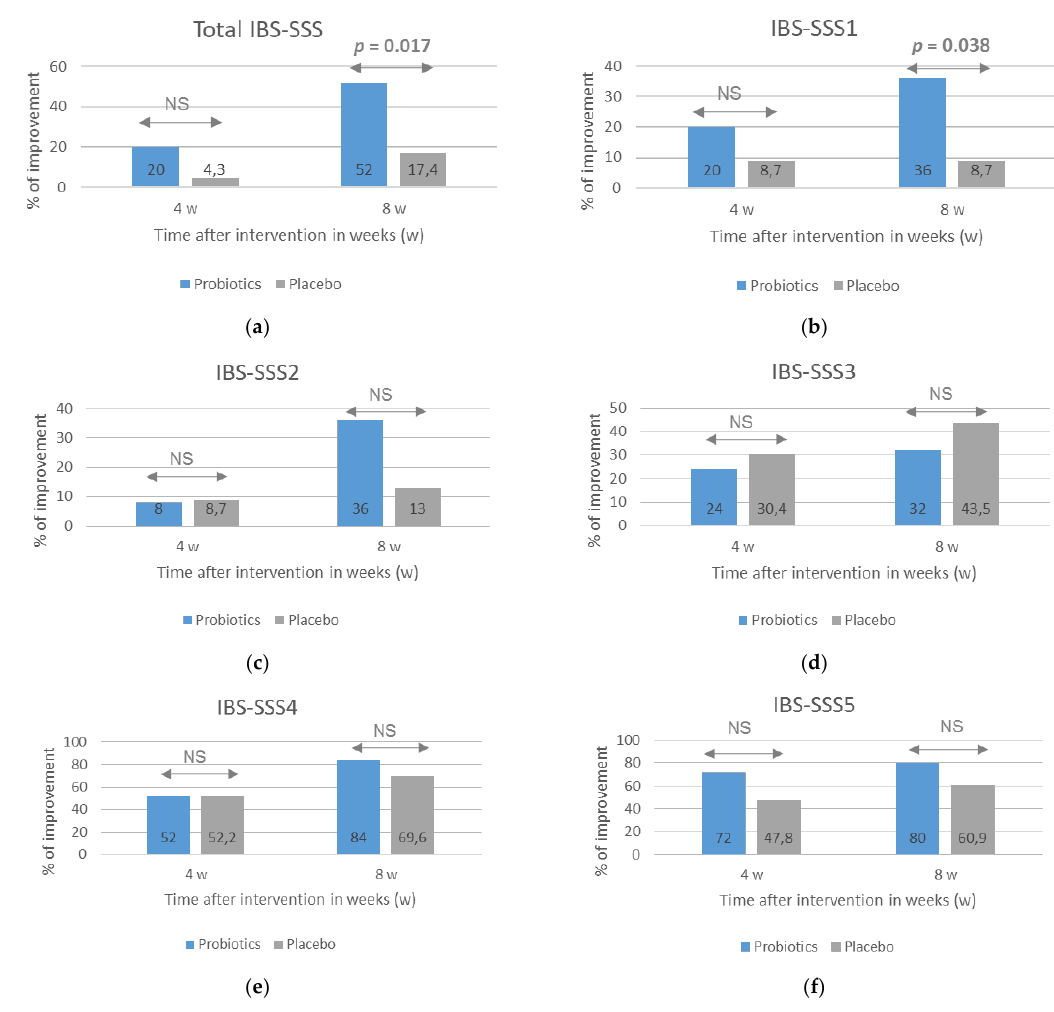
Figure 2. The percentage of patients with an improvement in IBS symptoms evaluated with the use of the IBS-SSS after probiotic treatment lasting 4 and 8 weeks. The total IBS-SSS score ( a ) and domain-specific scores related to the severity of pain ( b ), frequency of pain ( c ), dissatisfaction with bowel habit ( d ), severity of flatulence ( e ), and quality of life were analyzed (f). An improvement was defined as at least a 30% decrease in scores compared with baseline scores. NS = no significance ( p > 0.05). Statistical analysis performed with the use of Fisher’s exact test.